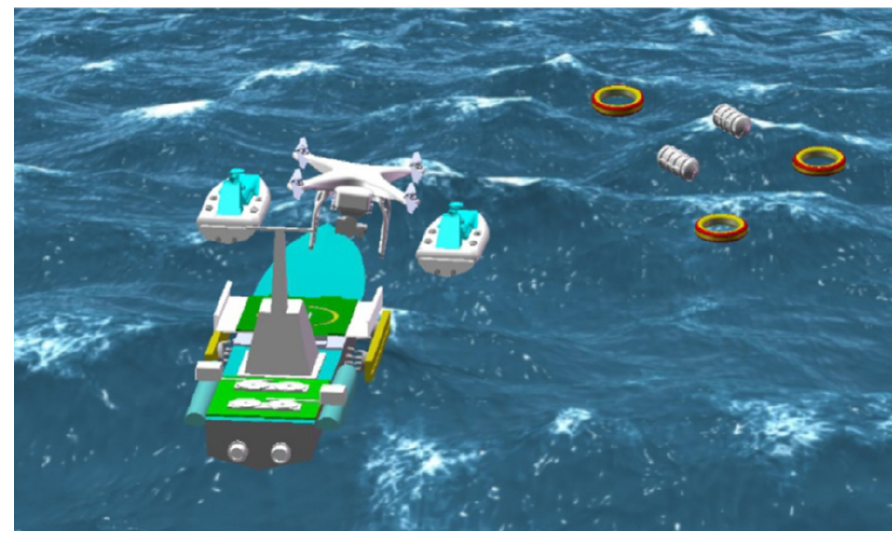
Figure 2. Schematic of the UAV and unmanned surface vehicle (USV) formation (Source: [21]).